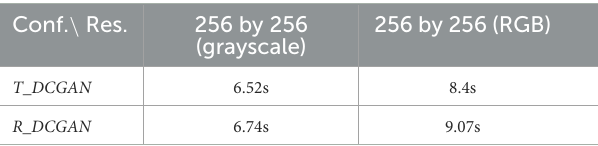
TABLE 2 Average epoch times of T_DCGAN and R_DCGAN with 1 channel (grayscale) and 3 channels (RGB) for the self-recorded data set. Conf. \